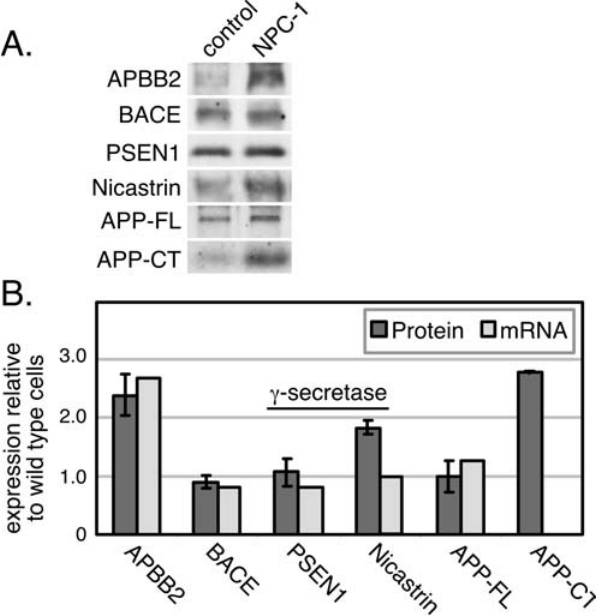
Figure 2. Links to Alzheimer’s disease at the mRNA and protein levels in NPC Cells. Protein levels in control and NPC-1 fibroblasts, determined by immunoblot (panel A), are quantified in B (dark shaded bars); mRNA levels from microarray data are shown in light shaded bars for comparison.